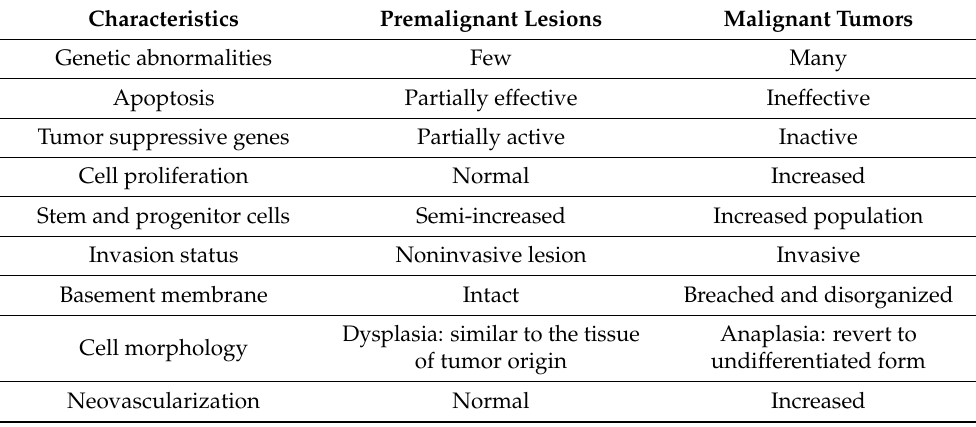
Table 1. Distinguishing Premalignant from Malignant